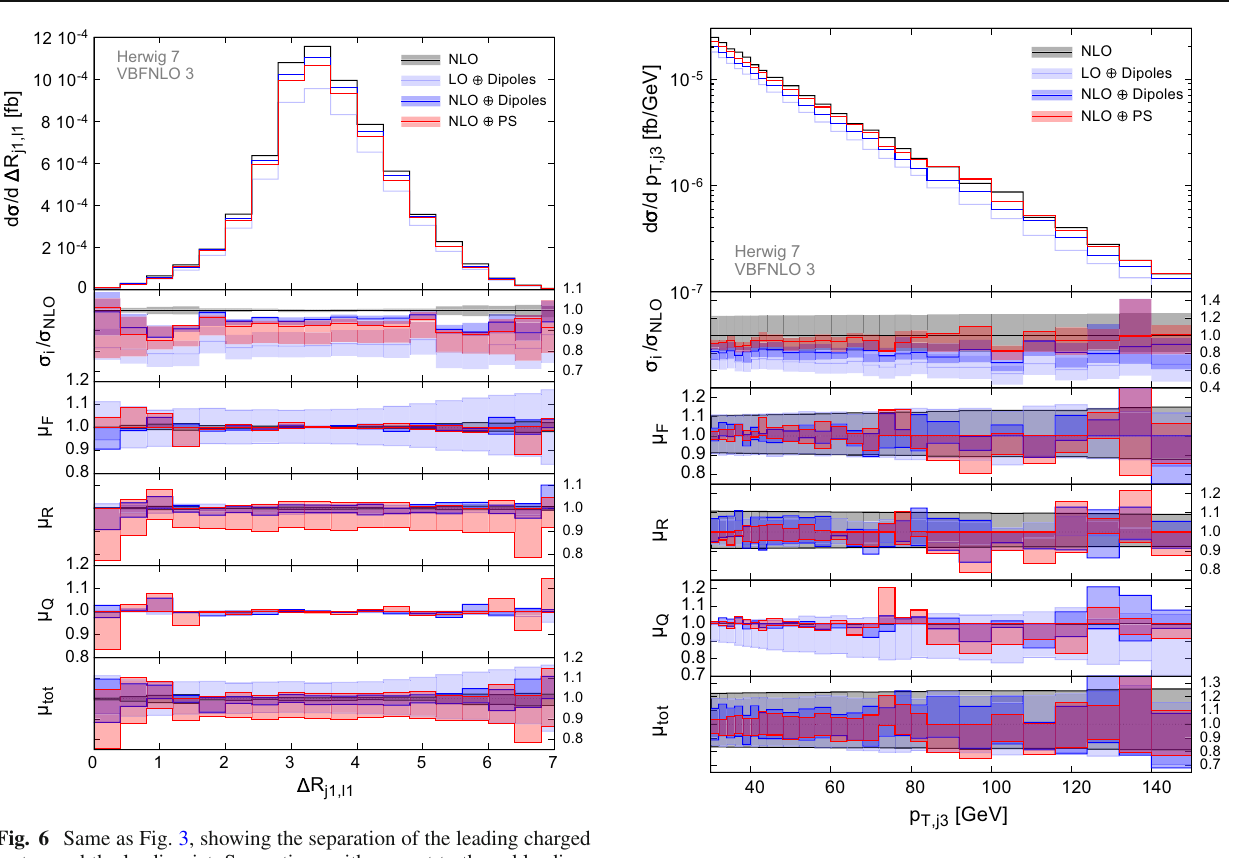
Fig. 7 The differential cross section for the transverse momentum of the third leading jet. See Fig. 3 and the text for more details nificantly affected by both the impact of NLO versus LO and the additional shower